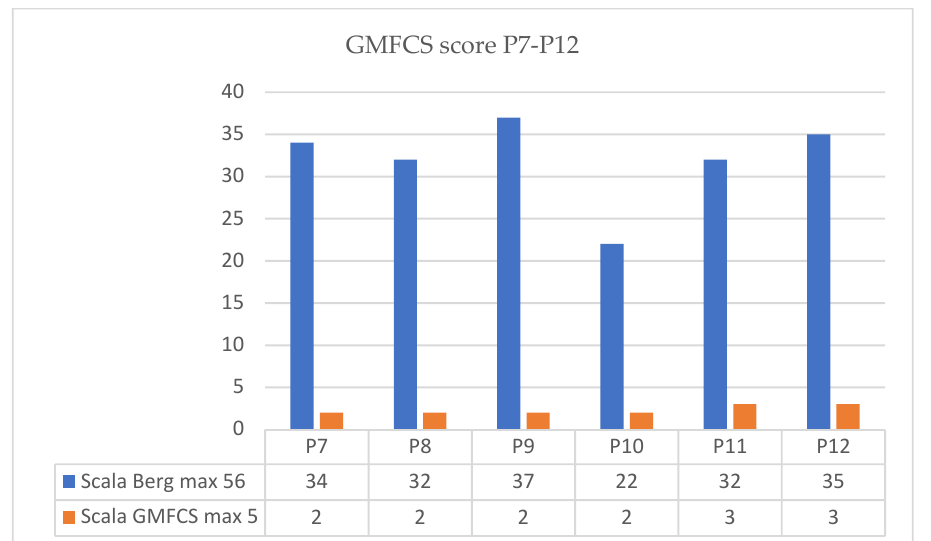
Figure 10. Evolution of GMFCS score patient P1–P6.